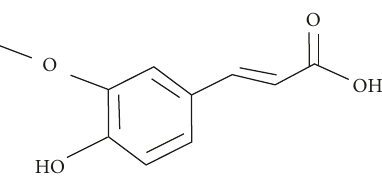
Figure 8: Chemical structure of ferulic